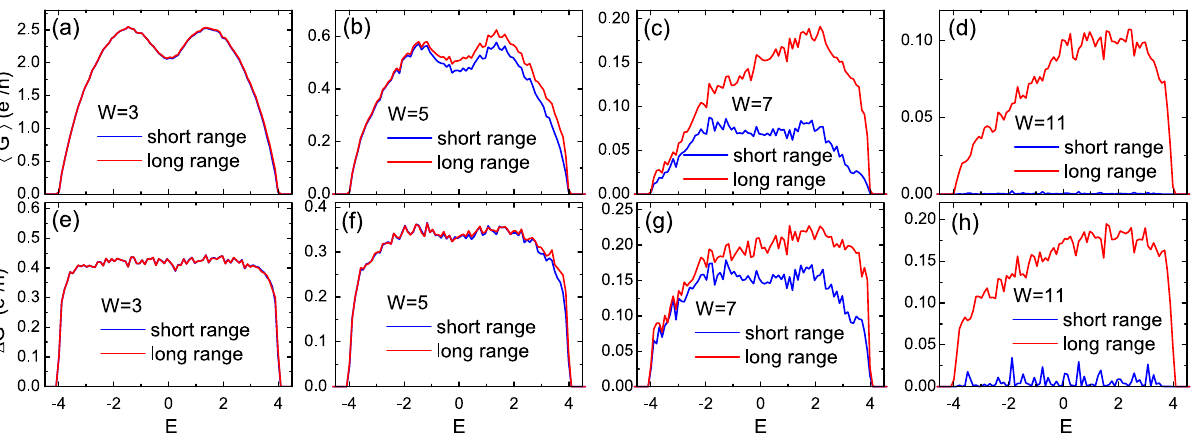
Figure 3. (Color online) The disorder averaged conductance (cid:31) G (cid:30) (first row) and its standard deviation (cid:31) G (second row) as functions of Fermi energy E , for different disorder strengths W as shown. The blue (red) curve is for the short (long) range model. The sample size is 40 × 40 and each data point is an average over 1000 disorder samples. All energies are in units of t